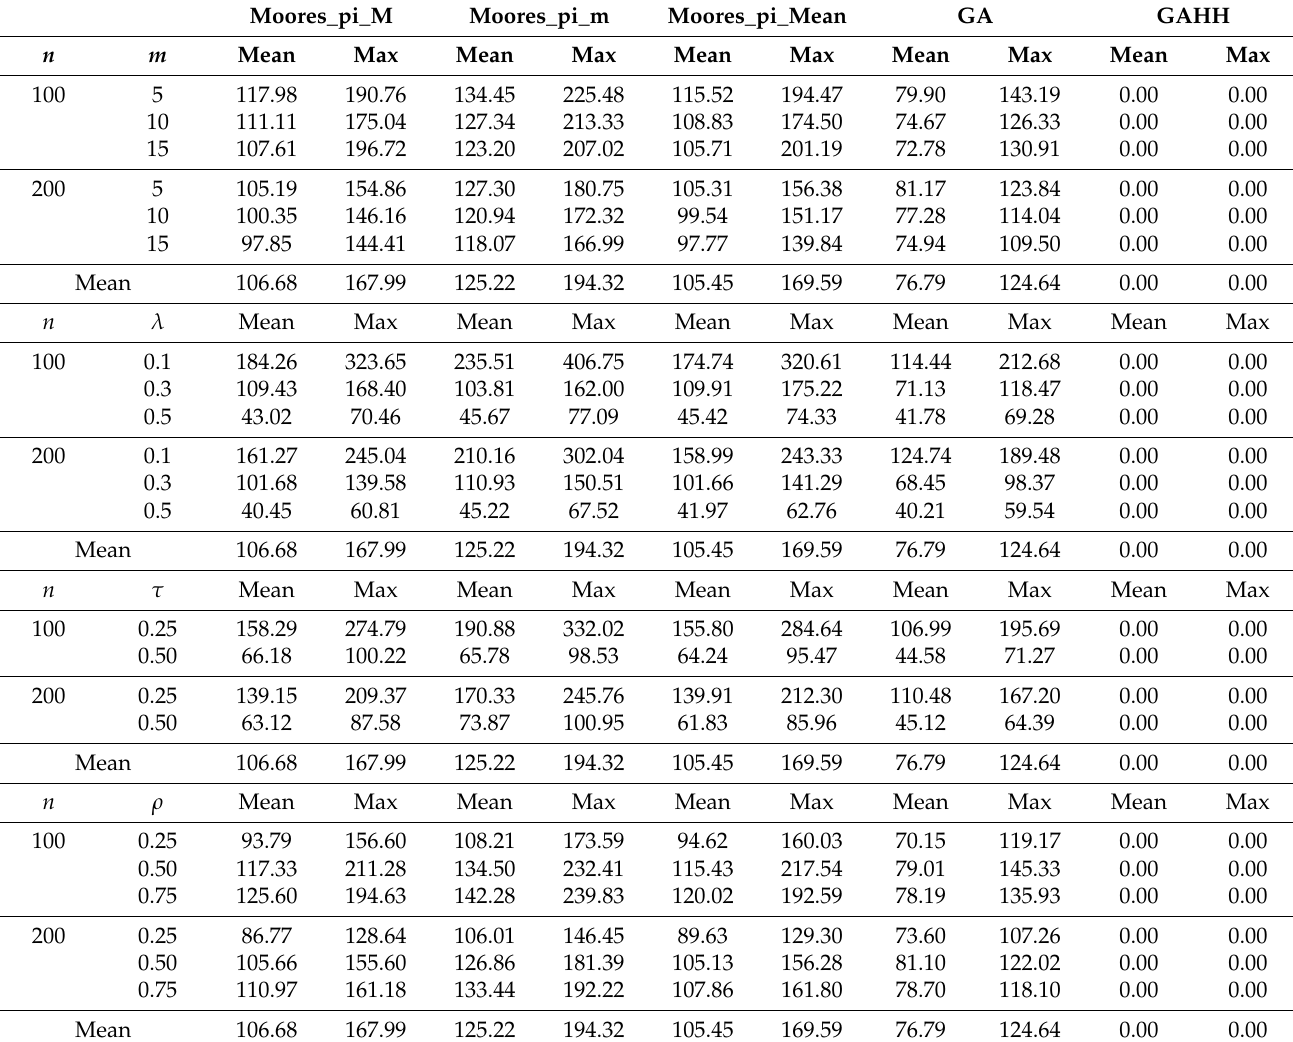
Table 4. RPDs obtained using proposed heuristics and algorithms for large n